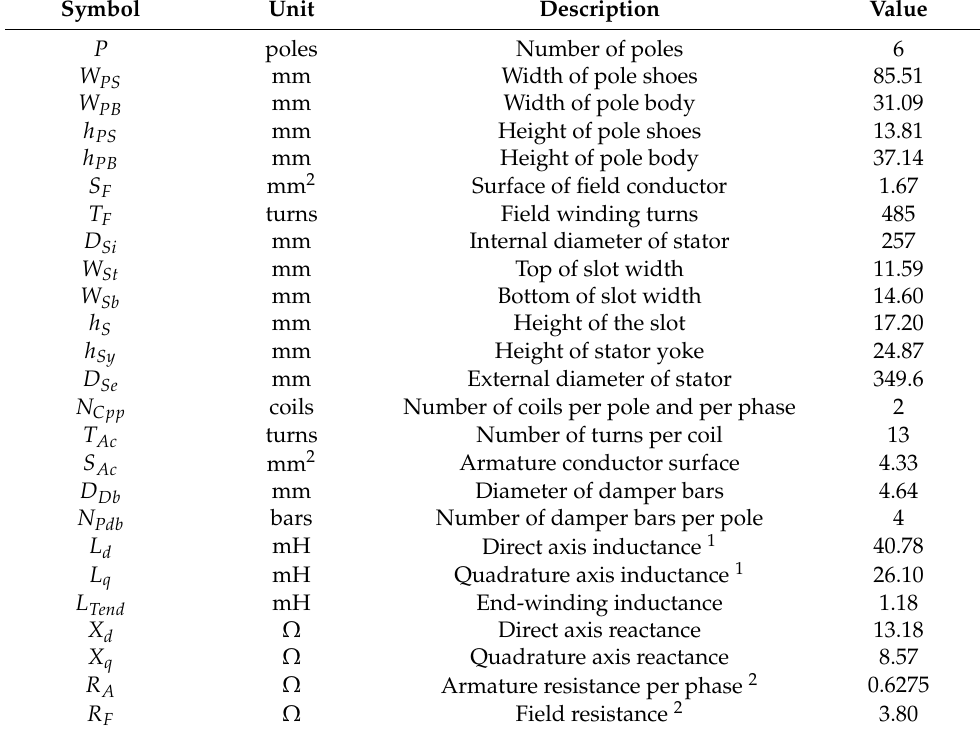
Table 3. Generator main results.